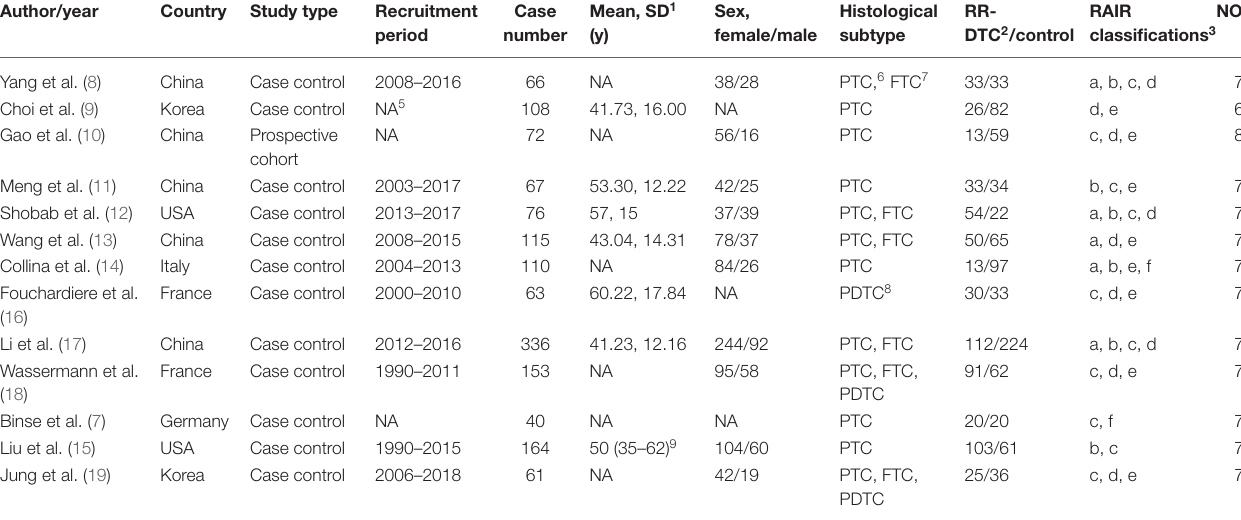
TABLE 1 | Characteristics of the selected